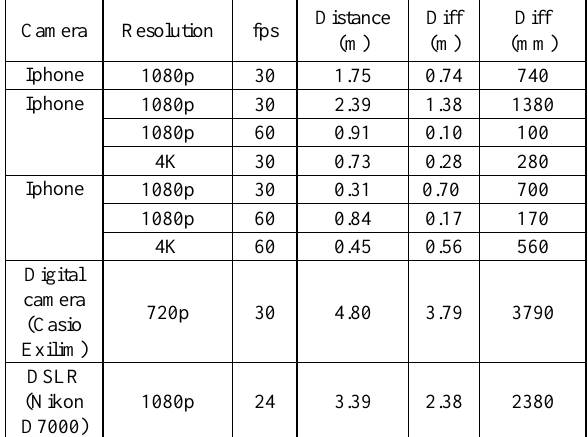
Table 3. Difference distance in y-axis